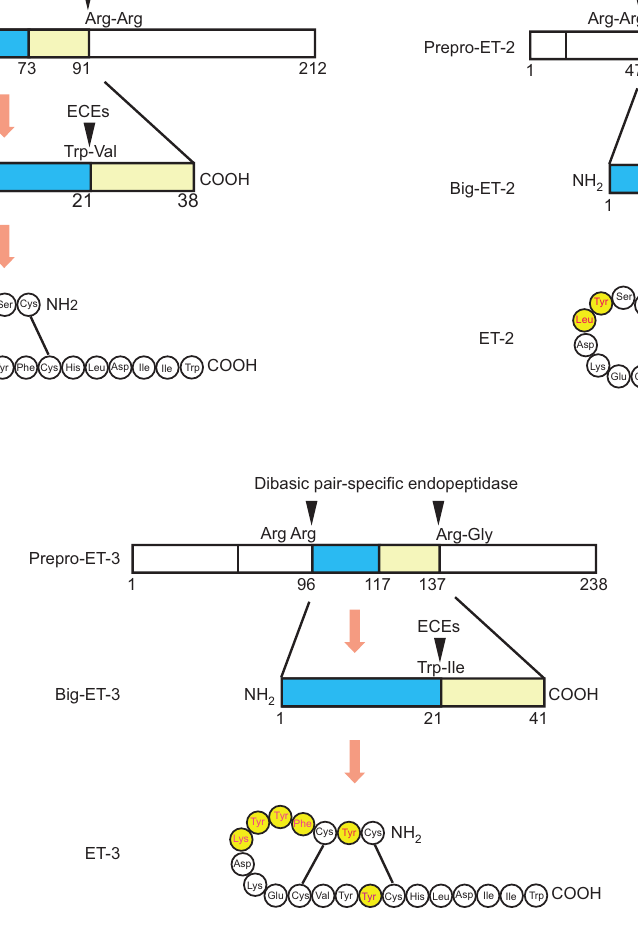
Figure 1 Biosynthesis of human ETs from prepro-ETs.